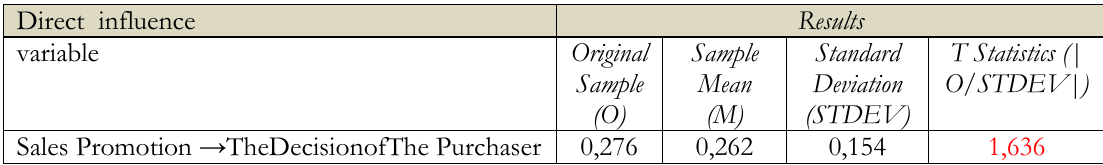
Table 8 Hypothesis Test